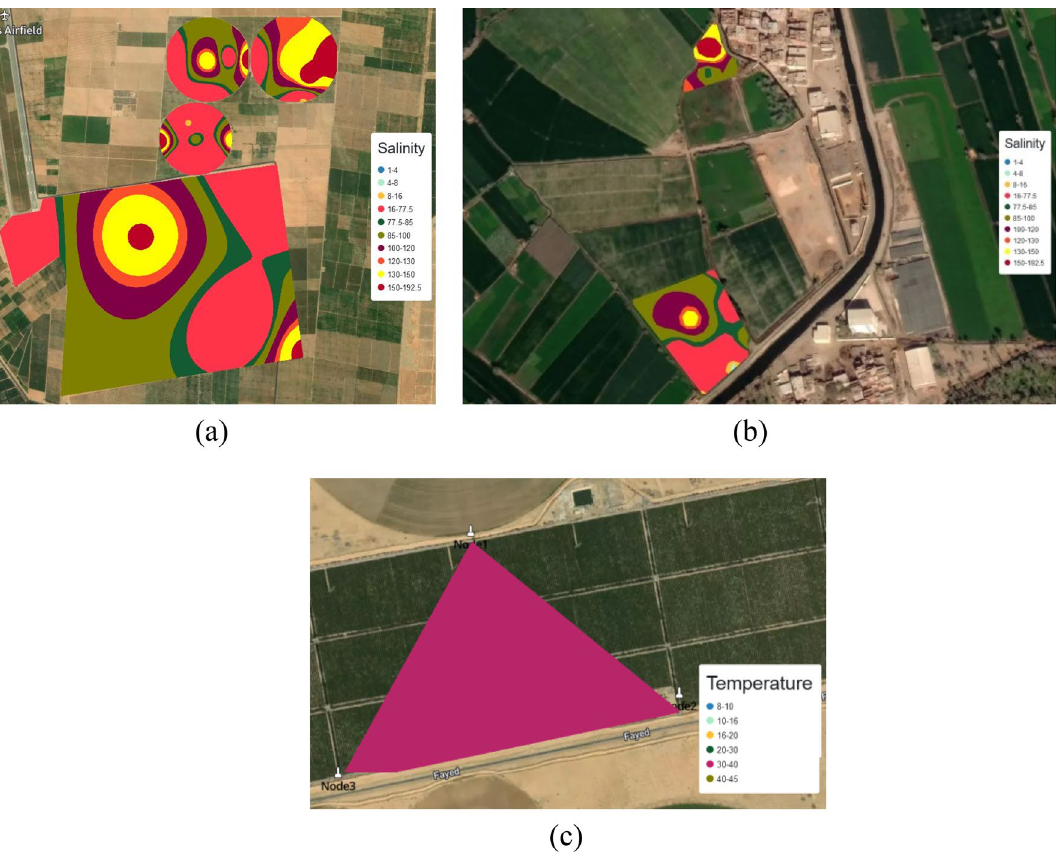
Figure 29. Different lands with different characteristics registered in the system, ( a ) examples of four lands of different area and geometry being monitored concurrently, ( b ) two other lands being monitored concurrently in different location, ( c ) another monitored land receiving data from real base